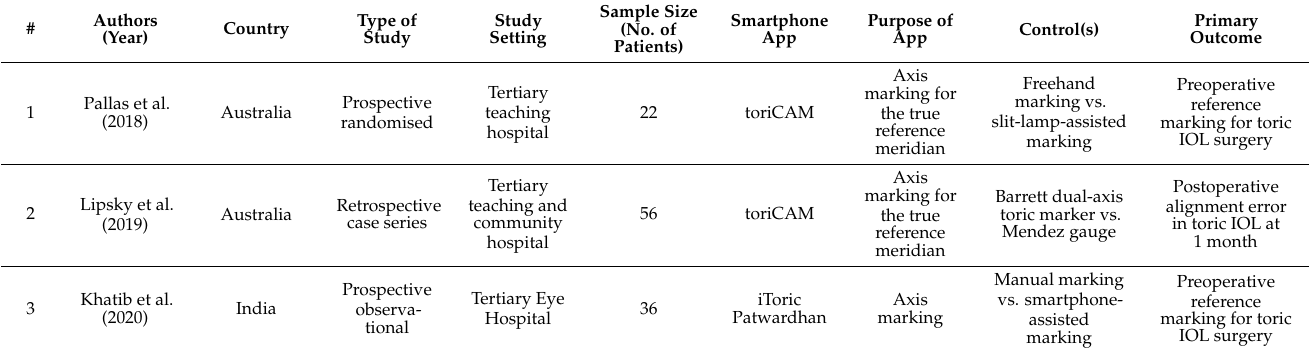
Table 4. Summary of included studies examining existing smartphone apps included in this study